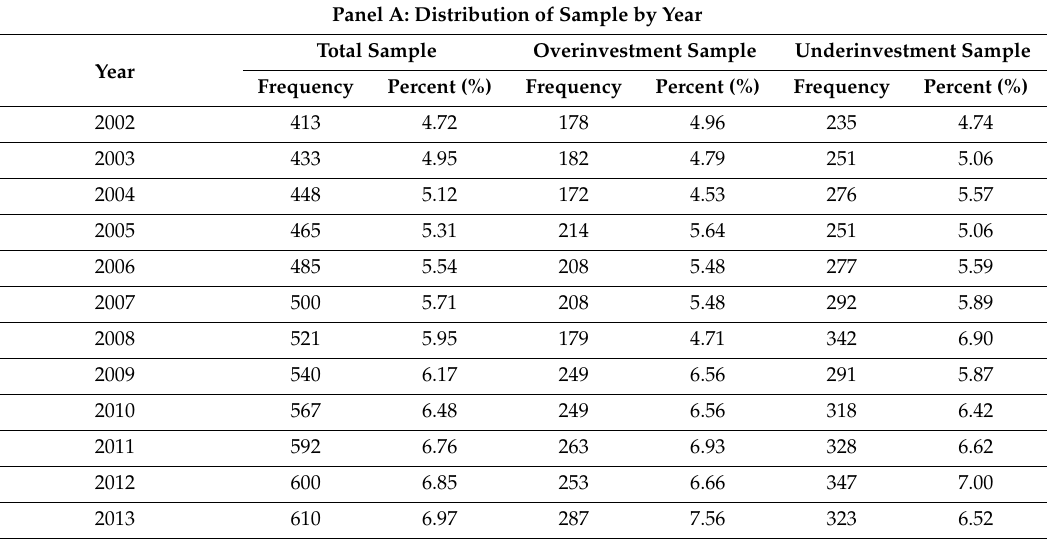
Table 2. Distributions over the sample